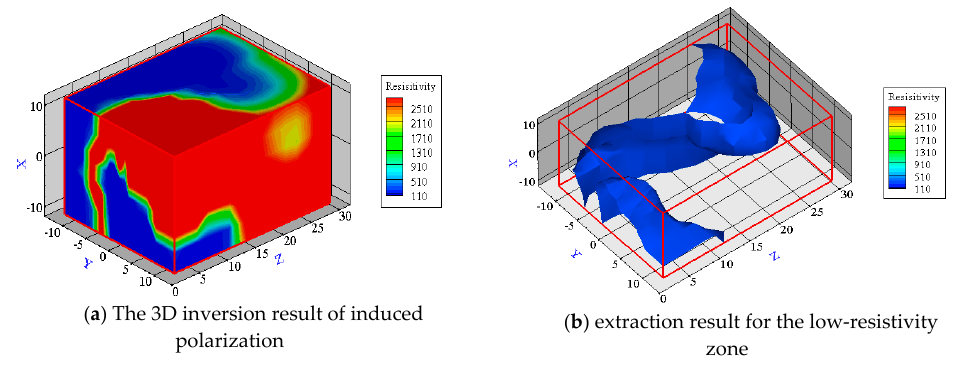
Figure 3. Induced polarization three-dimensional imaging.